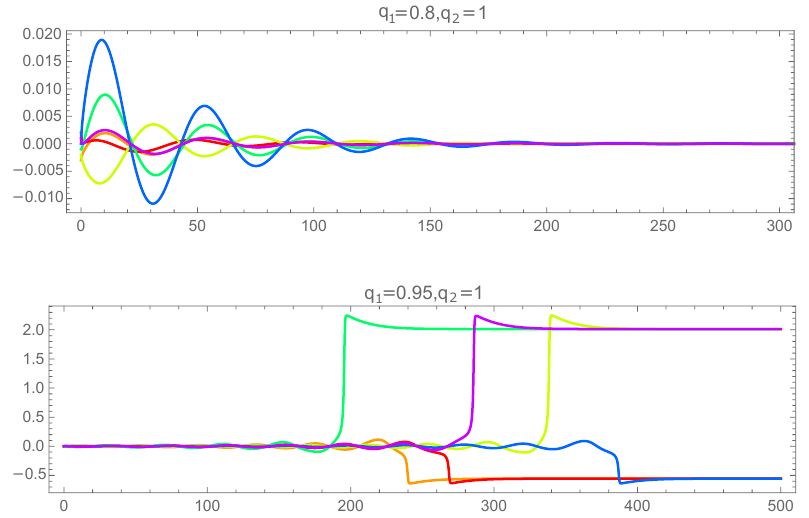
Figure 3. Evolution of the membrane potential v 1 for fixed parameter values a = 1.5, (cid:101) = 0.032 and β = 2, coupling coefficient g = 0.8, fixed fractional order q 2 = 1 and q 1 ∈ { 0.8,0.95 } , considering multiple initial conditions for system (3) in a neighborhood of the trivial equilibrium (corresponding solutions plotted with different